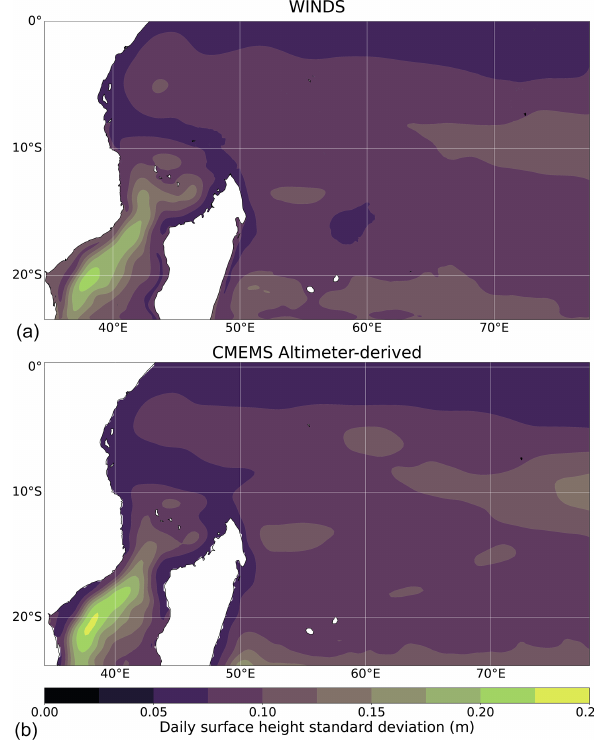
Figure 6. Variability of sea-surface height from 1993–2020 from WINDS (a) and the Copernicus Marine Environment Monitoring Service (CMEMS) Global Ocean Reprocessed Gridded L4 Sea Sur- face Height product (b) , computed as a standard